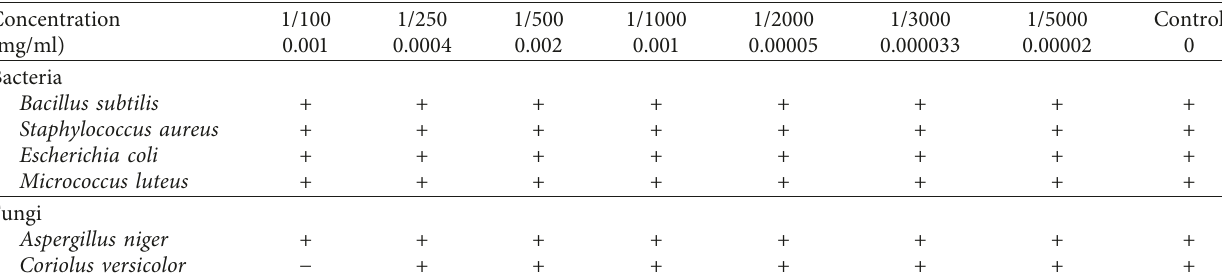
Figure 3: Percentage radical scavenging of the methanolic extract of Spirulina as per DPPH assay-expressed activity ( n concentration of the Table 5: Inhibitory volumes and minimum inhibitory concentrations of the methanolic extract of Spirulina (Morocco). Concentration 1/100 1/250